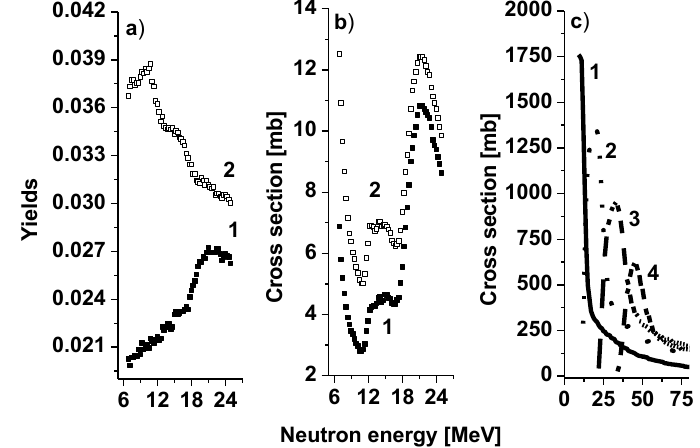
Fig.6. Yttrium isotopes production in 8 U(n,f). a) Relative yields of 98 Y; b) Production cross section of 98 Y. Neutron emission: 1 - pre; 2 - post. 89 Y(n,xn), x=1,2,3,4. Production of: 1 - 89 Y; 2 - 88 Y; 1 - 87 Y; c) Cross section production of Yttrium isotopes in (n,xn) reactions [21]. 1 - 89 Y; 2 - 88 Y; 3 - 87 Y; 4 - 86